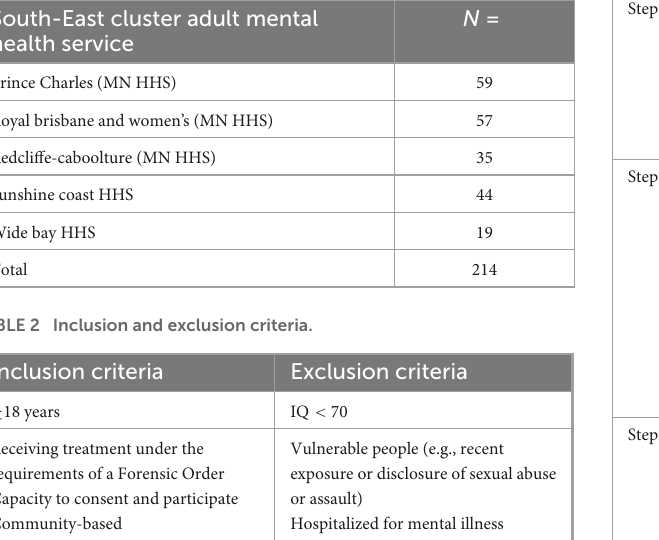
TABLE 1 Number of patients treated under the requirements of a forensic order as of November 2017 in the study area.